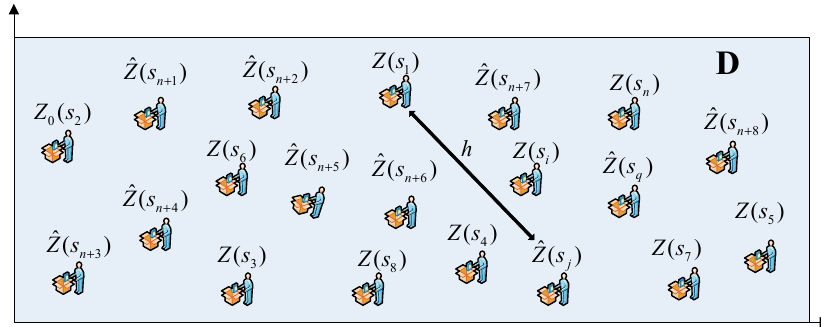
Figure 2. A limited two-dimensional area D with q recycling sites.